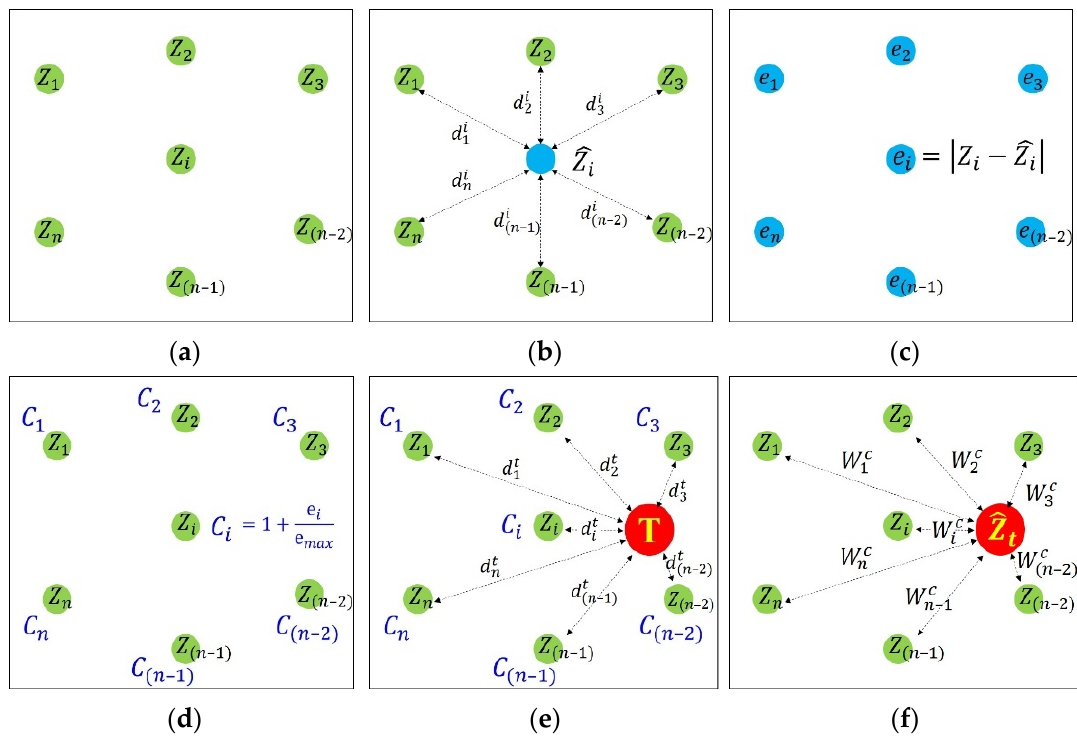
Figure 3. Modified IDW interpolation process. ( a ) Known points (and observed value at each point), ( b ) estimated calculation for known points (LOOCV), ( c ) LOOCV absolute error calculation, ( d ) cor- rection coefficient determination, ( e ) weight correction, and ( f ) interpolation using corrected weight.